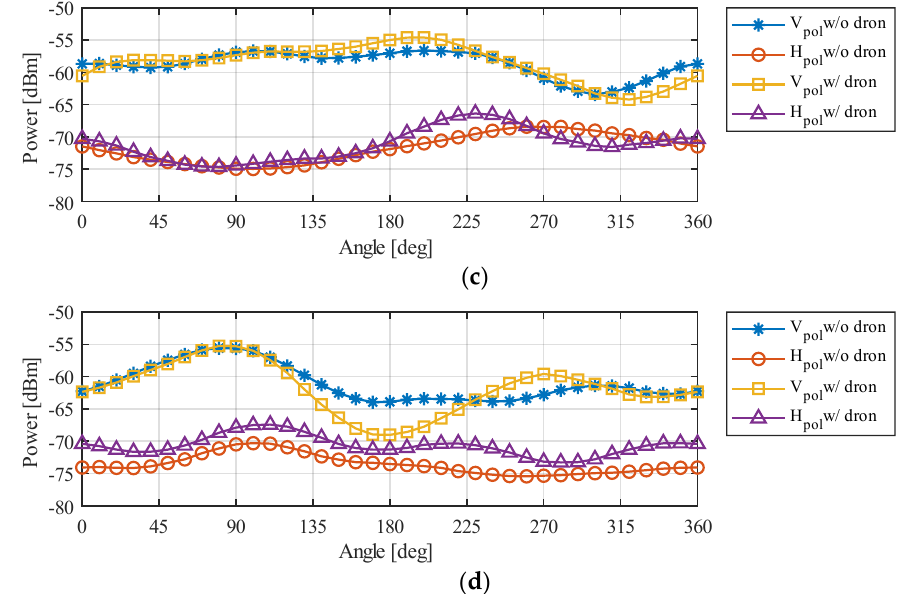
Figure 16. Influence of the UAV on the radiation pattern in: ( a ) 2.4 GHz band and X Plane, ( b ) 2.4 GHz band and Y Plane, ( c ) 5 GHz band and X Plane, and ( d ) 5 GHz and Y Plane.